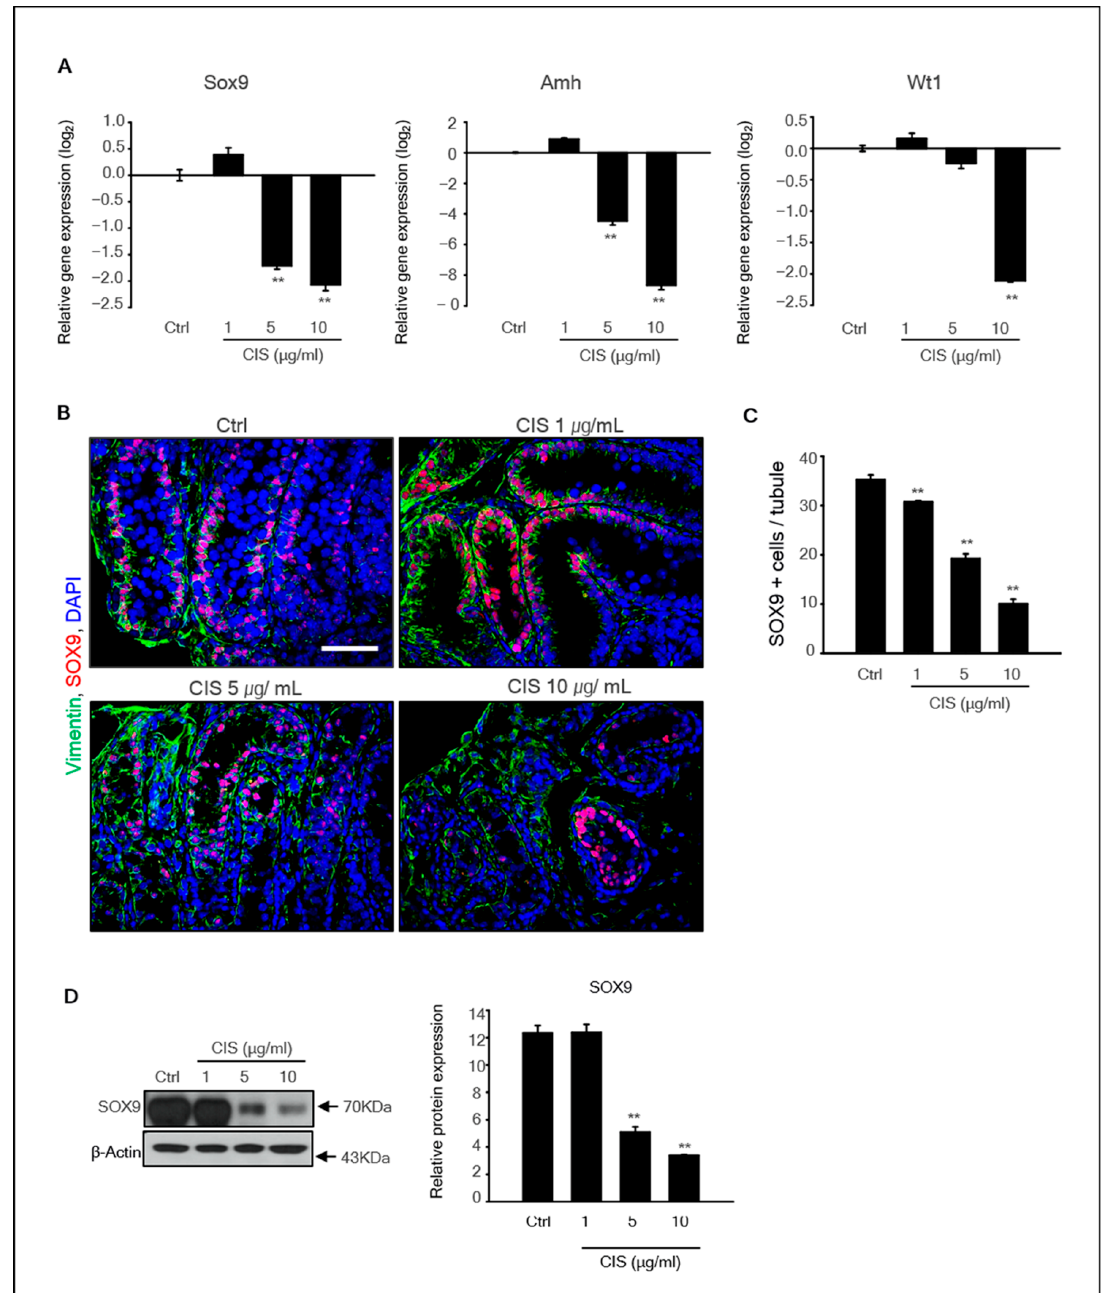
Figure 3. Effects of cisplatin on Sertoli cells in in vitro MTF culture. ( A ) The expression levels of Sertoli cell marker genes SOX9 , AMH , and WT1 in cisplatin-treated MTFs were determined by qPCR. Relative quantification of mRNA is shown as the mean and standard error of the mean ( n = 5) at the log 2 scale. ( B ) Double immunostaining of the MTFs section was performed using SOX9 and vimentin antibodies, which are known as Sertoli cell markers. Scale bars = 50 μ m. All images were acquired at the same magnification. ( C ) The number of SOX9+ cells in tubules was counted based on the immunostaining image. At least 40 tubules were scored for each MTF. The data are presented as mean and standard error of the mean ( n = 5), ** p < 0.01. ( D ) The expression of SOX9 protein was determined by immunoblot analysis in cisplatin-treated and -untreated MTFs. Quantitative analysis of the SOX9 protein is shown as the mean and standard error of the mean ( n = 5) at the log 2 scale. ** p < 0.01.